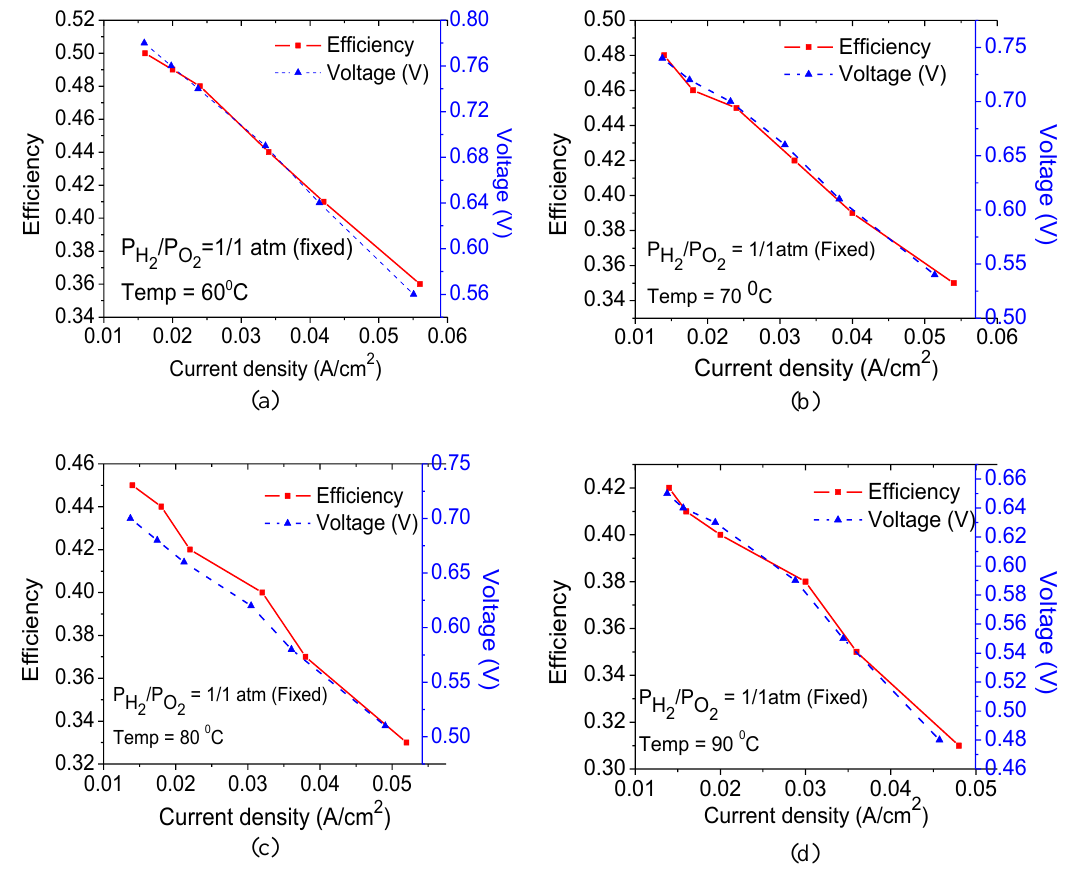
Figure 4. (a)-(d). Efficiency, current density and voltage at fixed reactants flow pressure and temperature variation